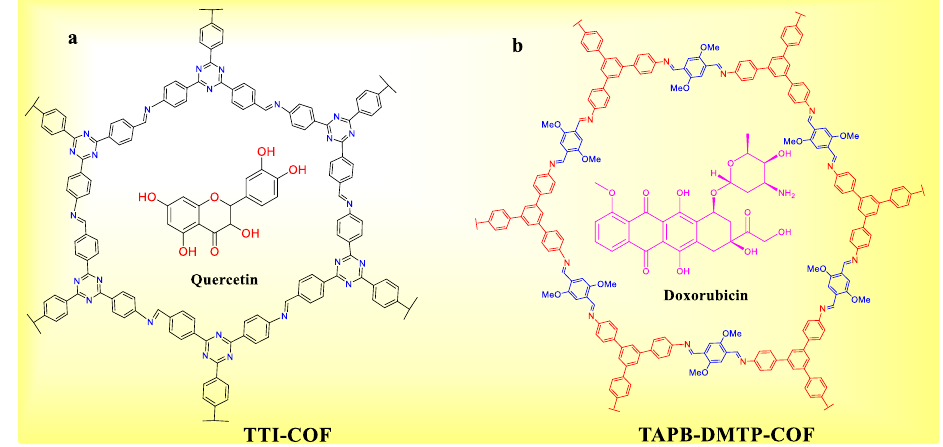
Figure 6. ( a ) Quercetin adsorbed on TTI-COF ( b ) Doxorubicin adsorbed on TAPB-DMTP-COF. PSM is used to decorate selected groups on COF surfaces in the first technique. In